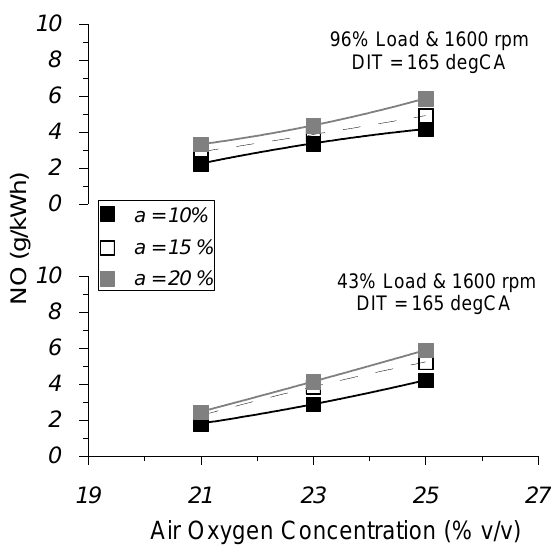
Figure 12. Calculated specific NO concentration versus “inlet-air oxygen ratio” for various “diesel fuel quantity ratios”, at 43% and 96% of engine rated load and 1600 rpm engine speed, for DIT = 165